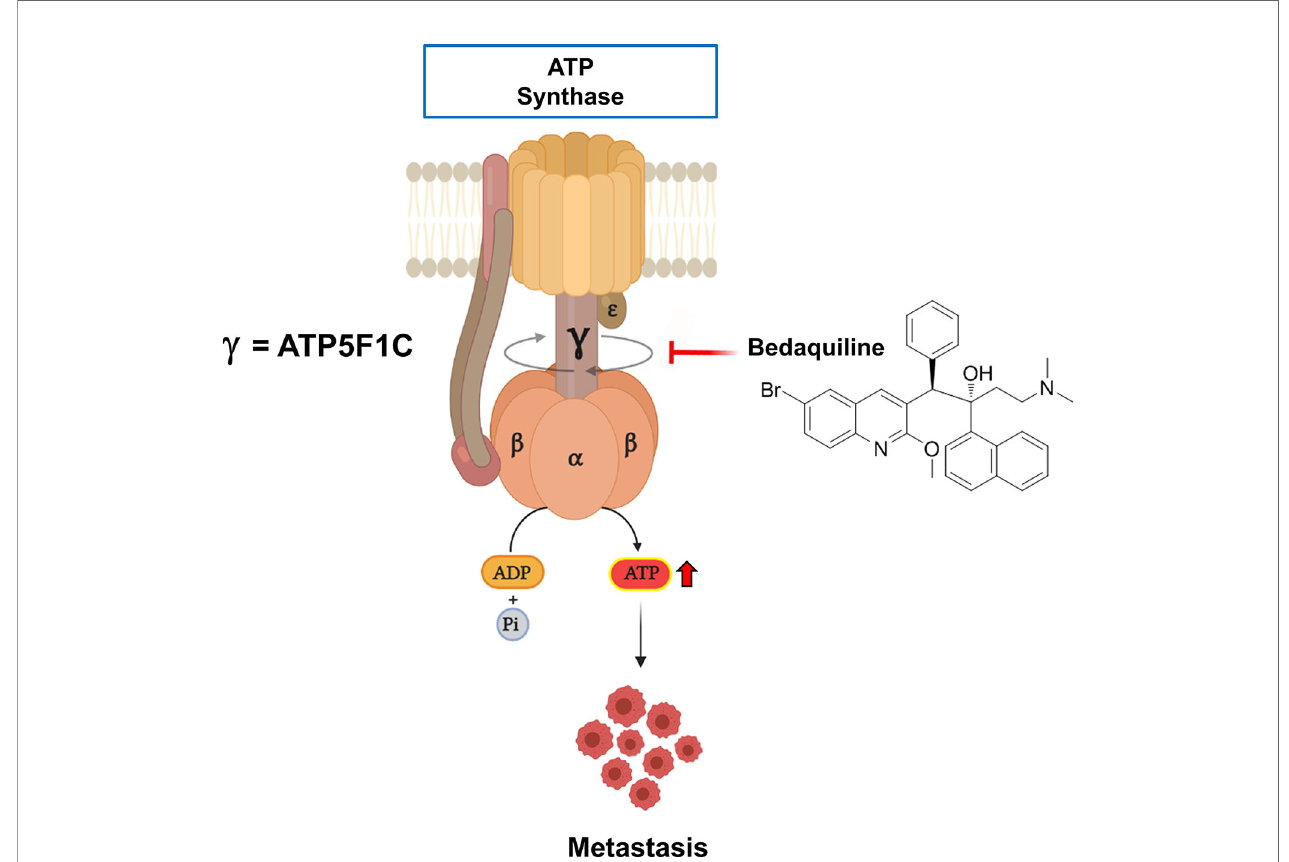
FIGURE 5 | Targeting the human mitochondrial ATP synthase with Bedaquiline, an FDA-approved drug, prevents spontaneous metastasis. Mitochondrial ATP- synthase is a nano-scale rotary molecular motor that uses the transport of hydrogen ions to generate physical energy in the form of torque that is then converted into chemical energy in the form of ATP. Rotation of the gamma-subunit (ATP5F1C) helps to convert physical energy into chemical energy. Note that Bedaquiline treatment induces the degradation or down-regulation of the gamma-subunit (ATP5F1C), resulting in ATP-depletion and the prevention of